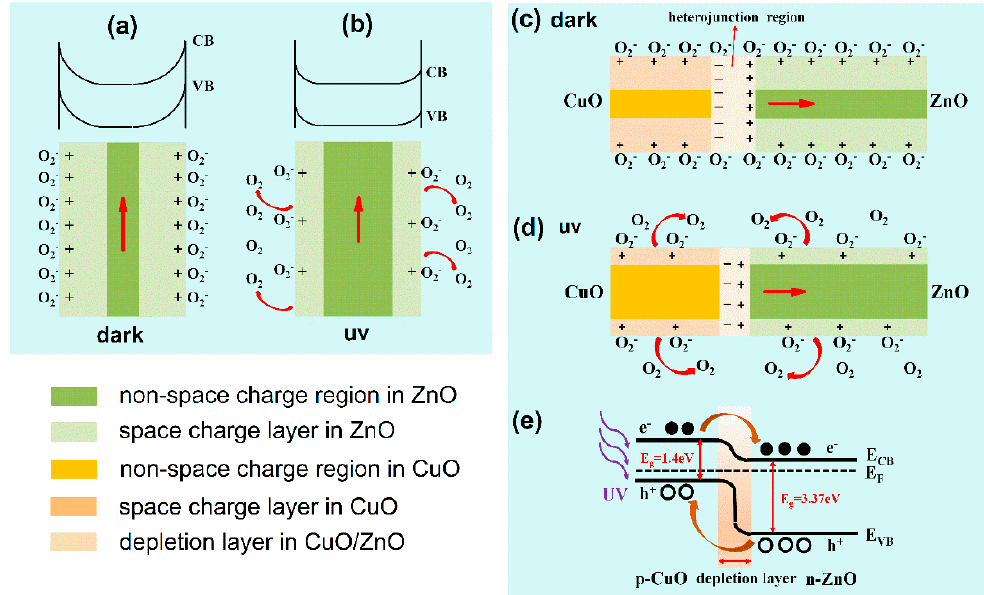
Figure 8. The barrier structure model of the ZnO NR UV photodetector under ( a ) dark and ( b ) UV environment. The barrier structure model of the ZnO / CuO heterojunction NR UV photodetector under ( c ) dark and ( d ) UV environment. ( e ) The energy diagram of the CuO / ZnO heterojunction NRs under UV illumination.